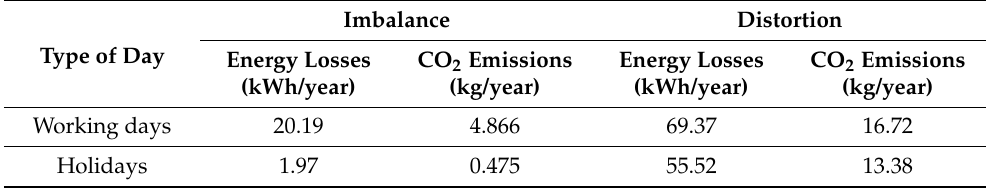
Table 7. Annual energy losses and CO 2 emissions caused by unbalanced ( W cu ) and distorted ( W ch ) currents in the transformer of the transformation